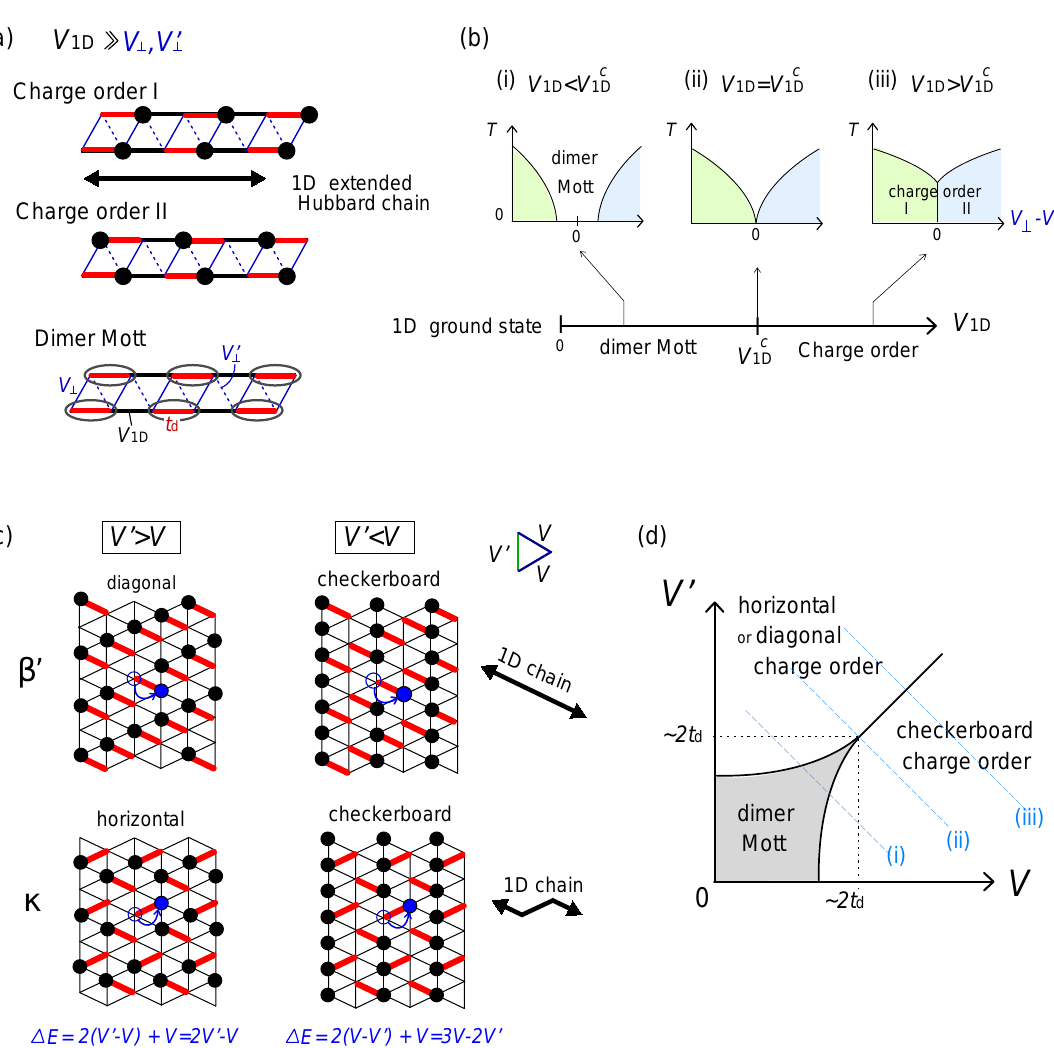
> t ) extended Figure 14. ( a ) Schematic illustration of the one-dimensional dimerized ( t d Hubbard chain interacting with U and V and coupled to neighboring chain via V and 1D ⊥ V (cid:48) ; ( b ) Schematic phase diagrams of model ( a ) on the plane of temperature ( T ) and ⊥ V − V (cid:48) , which Hotta constructed referring to the renormalization group and inter-chain ⊥ ⊥ mean-field results by Yoshioka et al. [51]. U (cid:29) V is shown in the lower panel. Depending on the relative strength of V against 1D 1D V c − V (cid:48) , the finite temperature phase diagram at finite V is classified into three cases; ⊥ 1D ⊥ ( c ) Dimerized ( t in bold red bonds) β (cid:48) - and κ -type of lattice structures based on the d anisotropic triangular lattice with V and V (cid:48) . The classical degeneracy of charge order at N/ 2 , become the unique ground states; ( d ) Schematic which maximally gain the energy by (cid:15) 2 ground state phase diagram of the dimerized extended Hubbard model on the lattices ( c ) at U (cid:29) t (cid:29) t , which Hotta depicted by regarding diagonal ( β (cid:48) ) and horizontal ( κ ) bond d directions as 1D